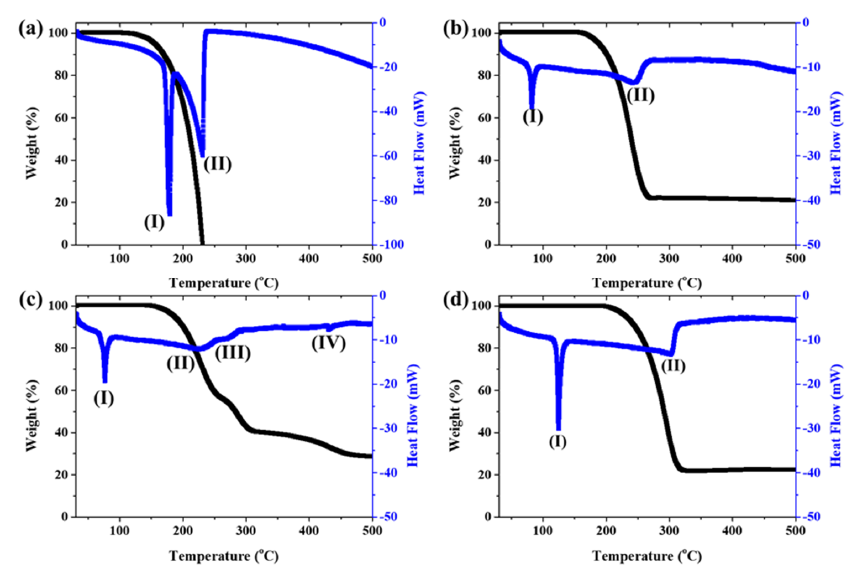
Figure 5. TG-DSC of catalyst precursors: ( a ) ferrocene, (b ) acetylferrocene, ( c ) ferrocenemethanol, and ( d ) 1,1′-diacetylferrocene.